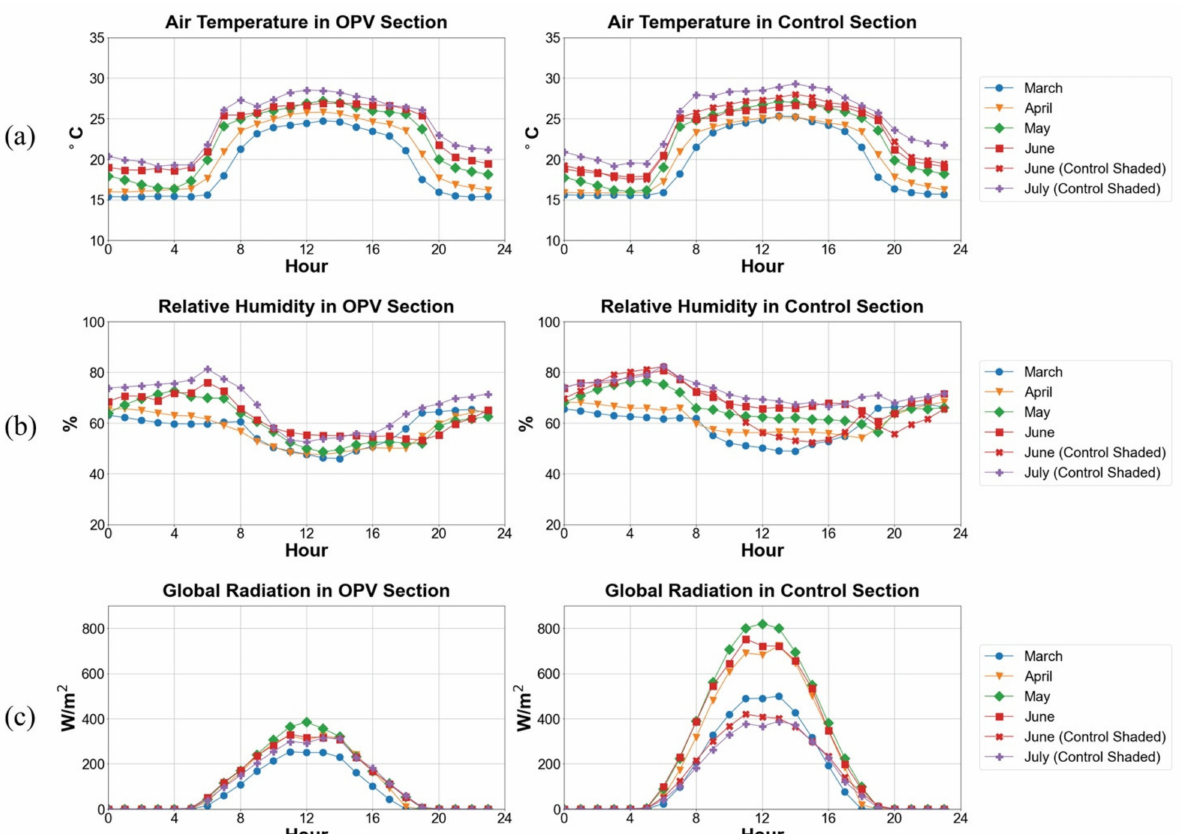
Figure 4. Average hourly values by month for ( a ) air temperature, ( b ) relative humidity, and ( c ) global radiation at the canopy level in the OPV ( left ) and Control ( right ) sections of the greenhouse during the growing period. Global radiation values are averaged from sensors on east, center, and west pyranometers in both OPV and Control sections. A 30% shade net was deployed on the Control section, beginning on 11 June